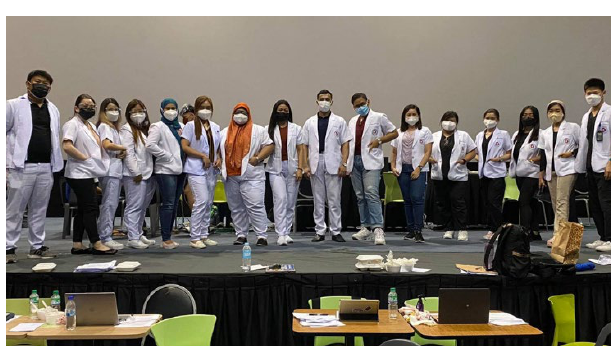
Figure 3 . PGIs as volunteers in one of the vaccination drives in the Philippines.